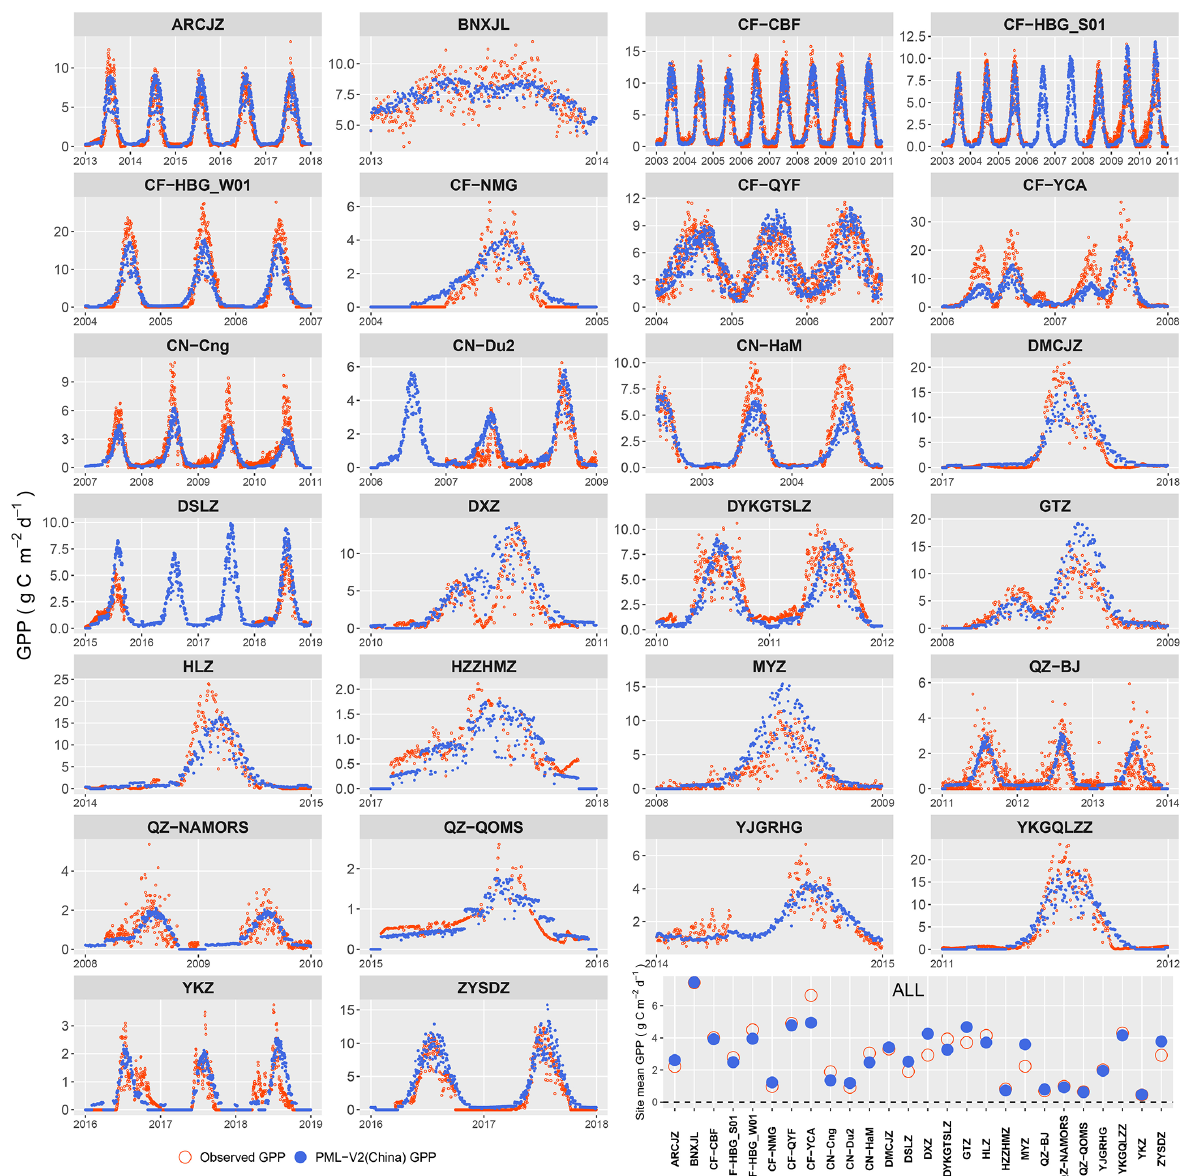
Figure 6. The daily GPP simulated by PML-V2(China) in calibration mode and the observed daily GPP variation in time series from 26 EC (see Fig. 2) sites over China. “ALL” represents the site mean value for each EC